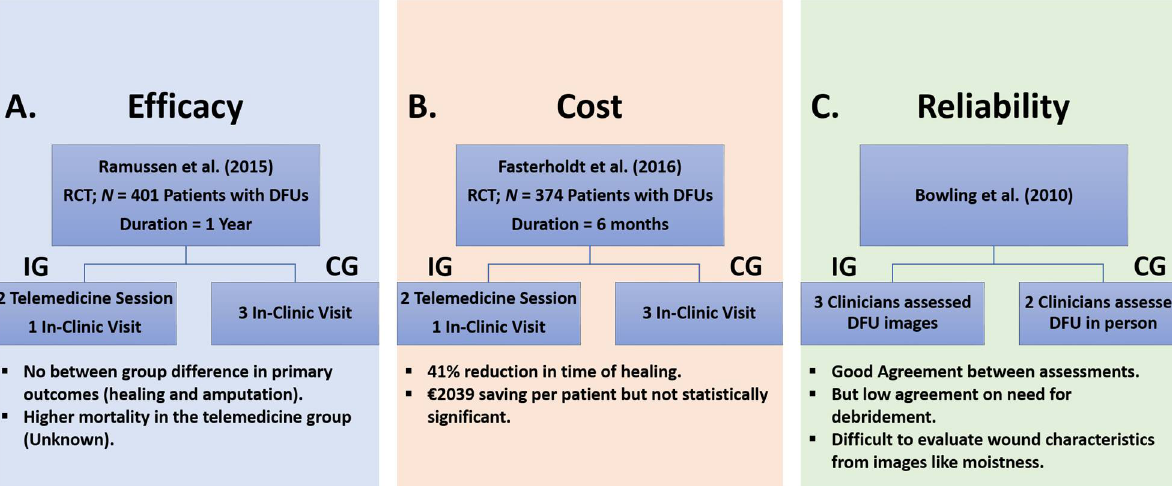
Figure 5. Recent studies support the efficacy, cost-effectiveness, and reliability of telemedicine support for DFU management. ( A ) In 2015 Rasmussen et al. demonstrated that by replacing 2/3 of in-clinic visits with telemedicine visits, the main outcomes (healing and amputation) would be similar to having all clinic visits [57]. ( B ) In 2018, Fasterholdt et al. showed that replacing face-to-face visits with telemedicine visits leading to a 41% reduction in total staff time used on outpatient consultations, which lead to noticeable cost-saving (approximately EUR 2039 for a patient) [58]. However, this reduction was not statistically significant in their sample ( C ) In 2011, Bowling et al. demonstrated a good agreement between assessment of 3D wound pictures and face-to-face assessment of wounds except for cases that needed debridement [59].